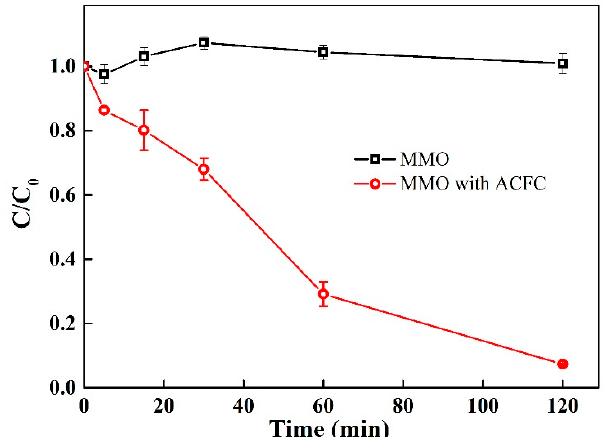
Figure 6. The loss of TA in 30 mL of a 50 mM Na 2 SO 4 solution with MMO grid as the anode or MMO grid with four ACFC layers as the anode, respectively. Error bars represent standard deviations ( n = 3). C 0 = 10 µM, cell voltage = 10 V.